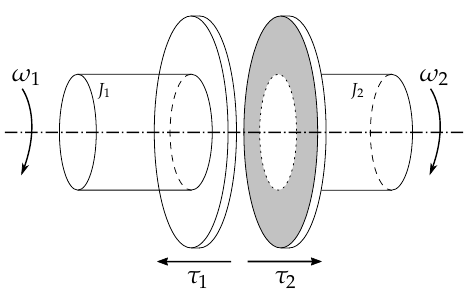
Figure 8. An ideal clutch with two